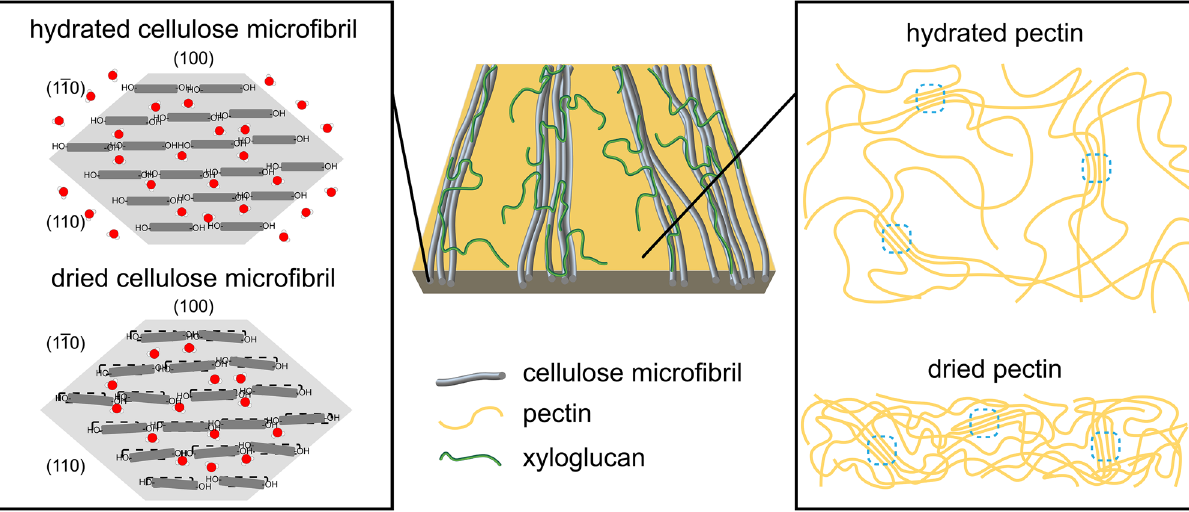
Figure 4. Proposed model of dehydration in primary cell wall. (Left) Changes in cellulose chain organization before and after dehydration. Dark gray bars indicate glucan chains. Water molecules outside of the light gray hexagon represent bulk water. Water interacts strongly with the (110) and ( 110 ) surfaces in the hydrated state due to the presence of hydroxymethyl groups along the sides of the chains. Upon dehydration of bulk water, cellulose chains contract towards the center of the microfibril, parallel to (100), decreasing the ( 110 / 110 ) spacing. The (200) lattice spacing does not collapse, possibly due to the presence of water molecules between the sheets. Chain packing disorder of glucan chains increases following dehydration. Dotted areas indicate the position of glucan rings prior to dehydration. (Middle) Illustration of a single lamella of primary cell wall based on coarse-grained simulations 65 . (Right) Changes in pectin assembly before and after dehydration. Water fills the gaps between loosely packed pectins, which vertically collapse after dehydration. A weakly ordered pectin chain aggregate, indicated by blue dashed lines, is preserved after the dehydration-induced collapse of the